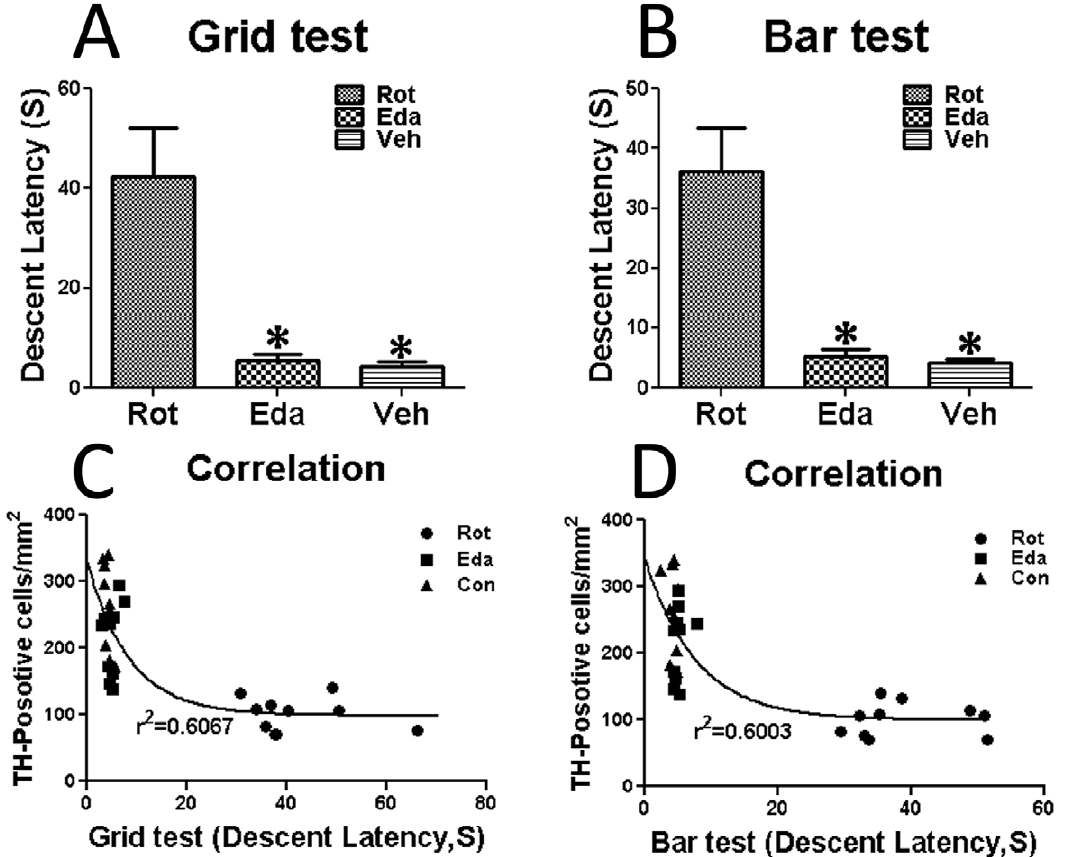
Figure 1. Catalepsy test of experimental animals (five weeks after the first administration of drugs). (A), (B), descent latency of Rot-, Eda- and Veh-group by Grid test and Bar test, respectively (*P , 0.05 as compared to Rot-group); (C), correlation between SN TH-positive cell numbers and Grid test scores; (D), correlation between SN TH-positive cell numbers and Bar test scores.